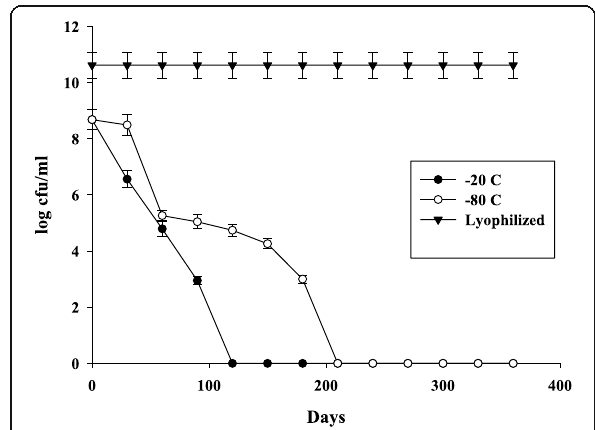
Fig. 5 Population dynamic of Chromobacterium violaceum strain TRFM-24 in conventional standard preservation